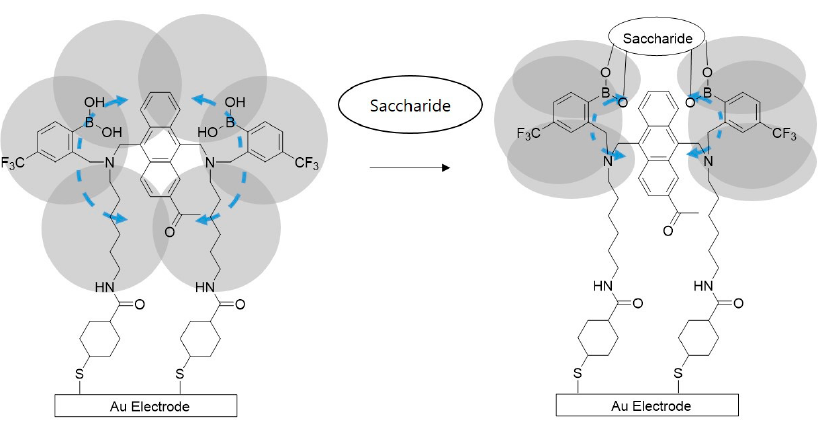
Figure 5. Simplified illustration to depict space occupied by moving phenyl rings depending on interacting with saccharide molecules. The gray area indicates space generated by rotating or vibrating phenyl rings. Freely moving phenyl rings should occupy more space than saccharide-linked ones.